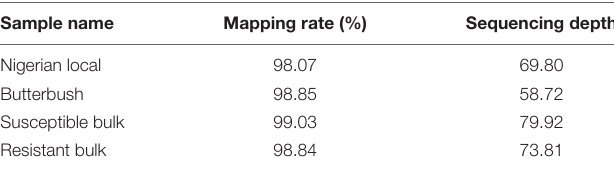
TABLE 1 | Whole genome re-sequencing statistics for resistant and susceptible parents and the corresponding bulks used in the study.